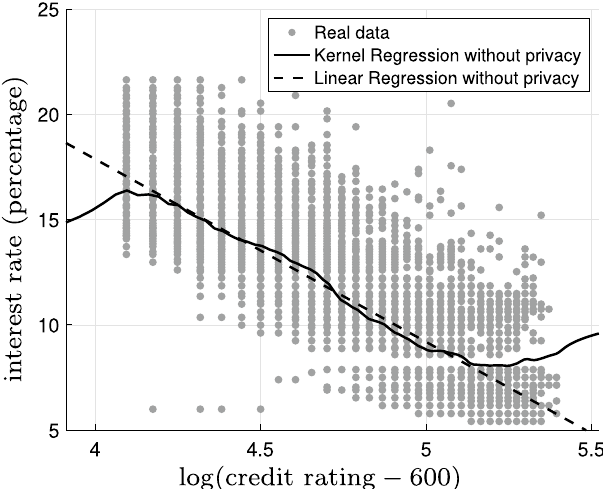
Figure 4. The kernel regression model (solid black) and the linear regression model (dashed black) based on 0.02 superimposed on the original noiseless data (gray dots). The mean the original data with bandwidth h = squared error for the kernel regression model is 4.42 and the mean squared error for the linear regression model is 4.61.